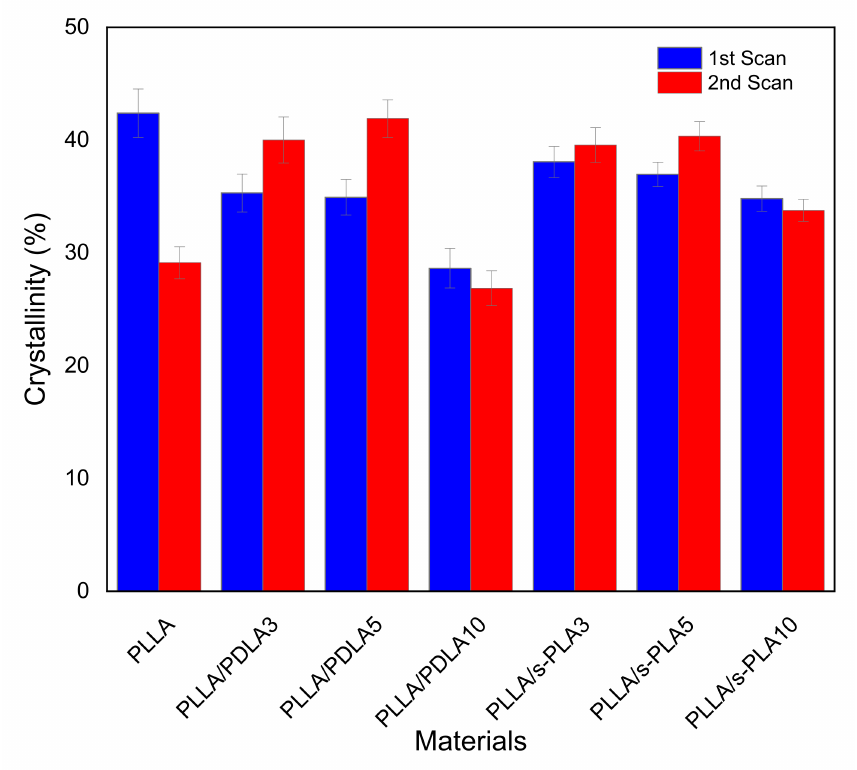
Figure 3. DSC thermogram of first and second scan for PLLA homopolymer, PLLA/PDLA blends, and PLLA/s-PLA blends at scanning rate 10 ◦